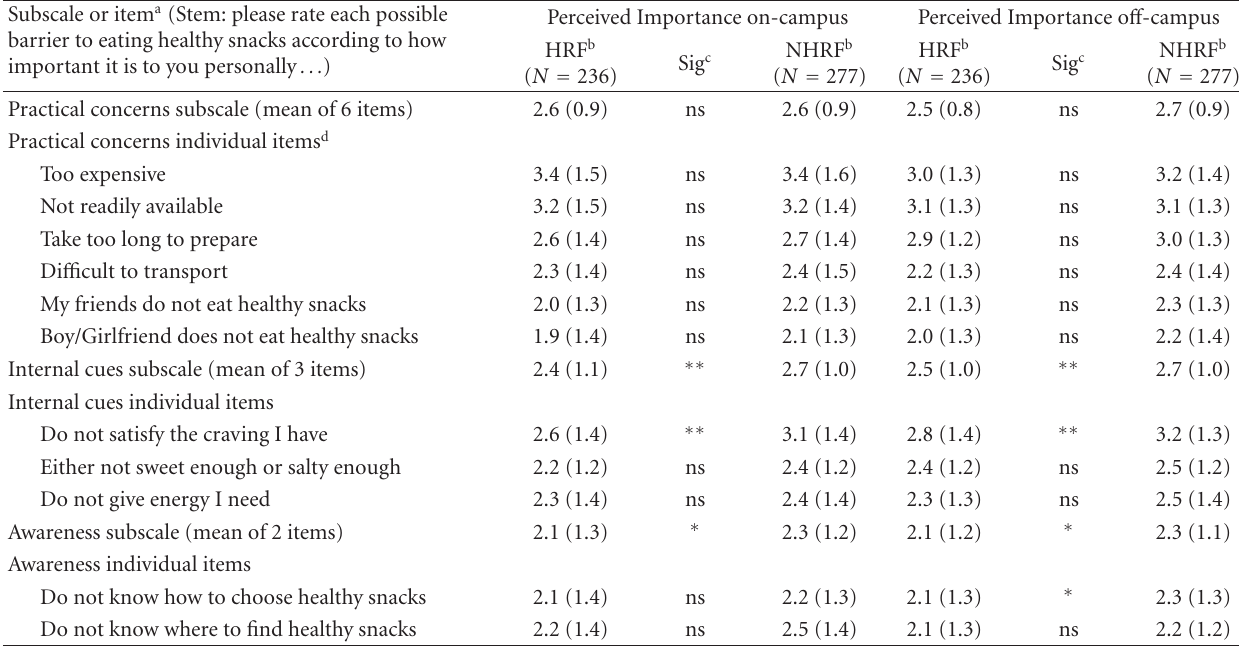
Table 1: Mean importance ratings of barriers to healthy snacking on-campus and o ff -campus for 513 college students. Subscale or item a (Stem: please rate each possible barrier to eating healthy snacks according to how important it is to you personally ... )